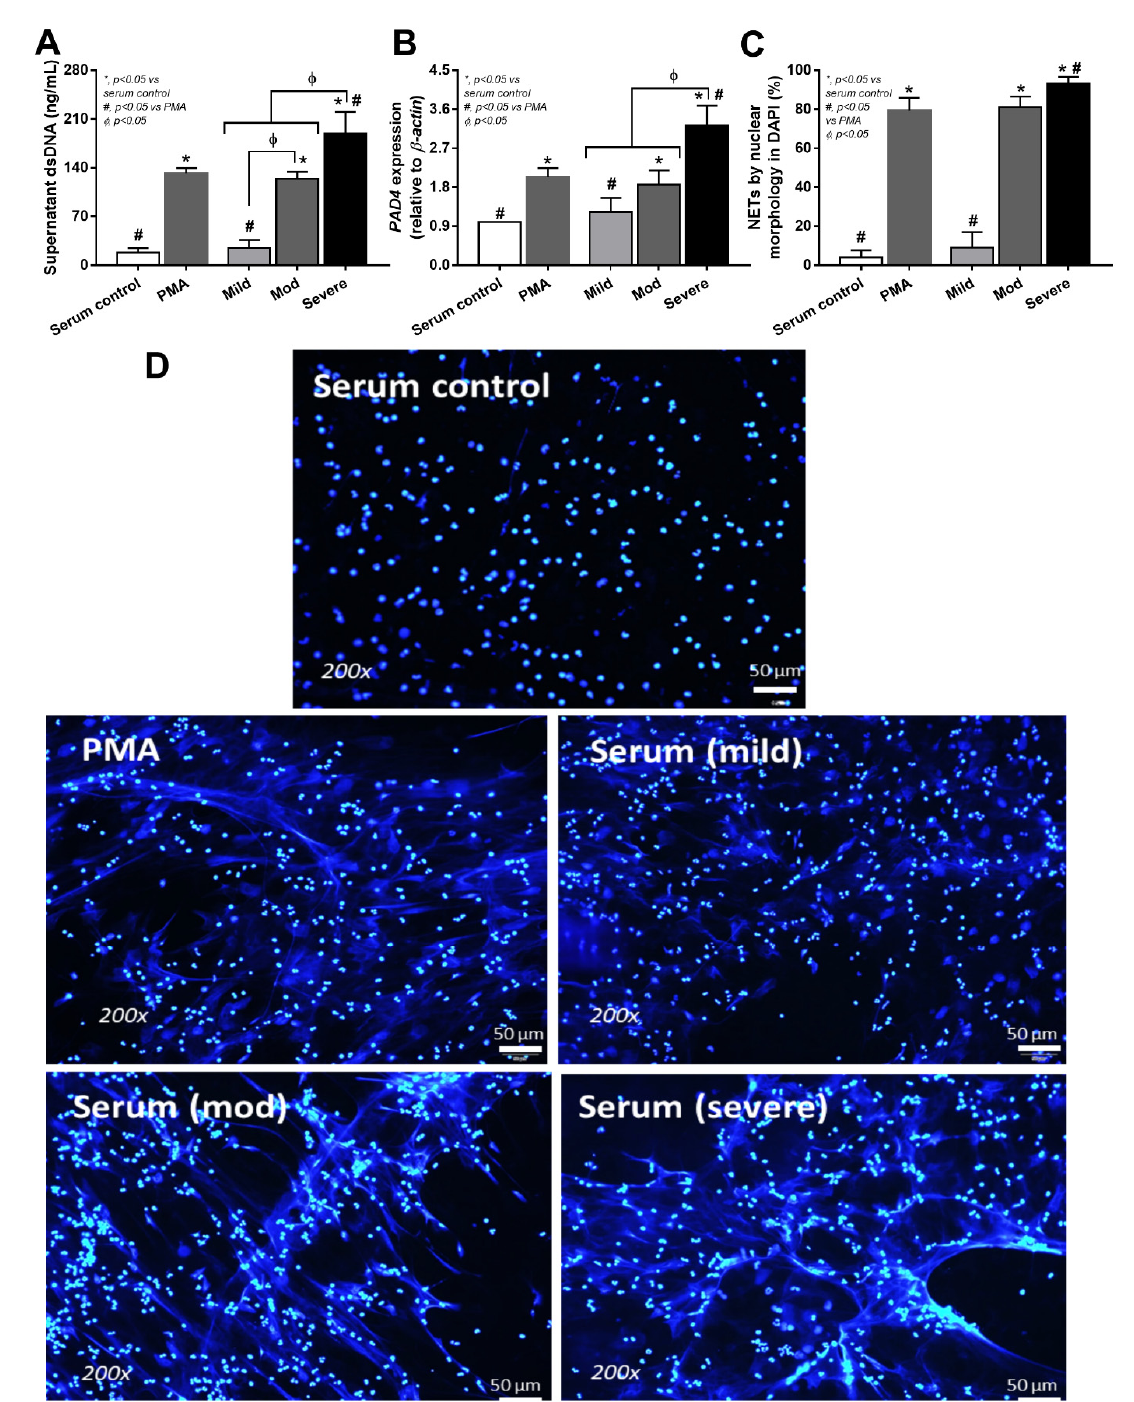
Figure 5. Neutrophil extracellular traps (NETs) of the isolated neutrophils from healthy volunteers after activation by control serum and serum from cases with different COVID-19 severities, using Phorbol 12-myristate 13-acetate (PMA) as a positive control of NETs inducers, as indicated by supernatant dsDNA ( A ), Peptidyl Arginine Deiminase 4 ( PAD-4 ) expression ( B ), and morphology of DAPI nuclear staining with the representative pictures ( C , D ) (the cells from 7 volunteers were used in all activations). * p < 0.05 vs internal serum control groups, Φ p < 0.05 between the indicated groups and # p < 0.05 vs PMAas determined by ANOVA with Tukey’s analysis.